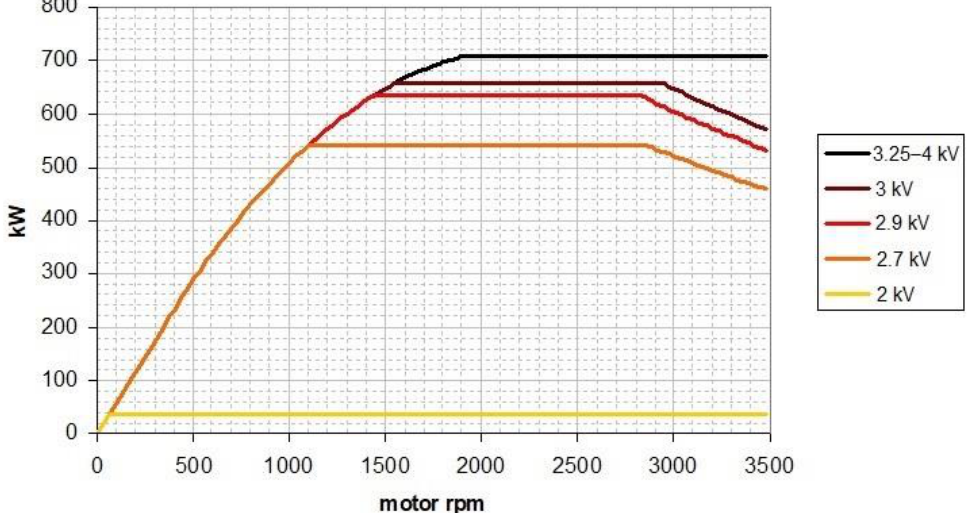
Figure 3. Dependence between power developed by a traction motor of ED250 train on its rotational speed and voltage at pantograph. Source: Alstom.